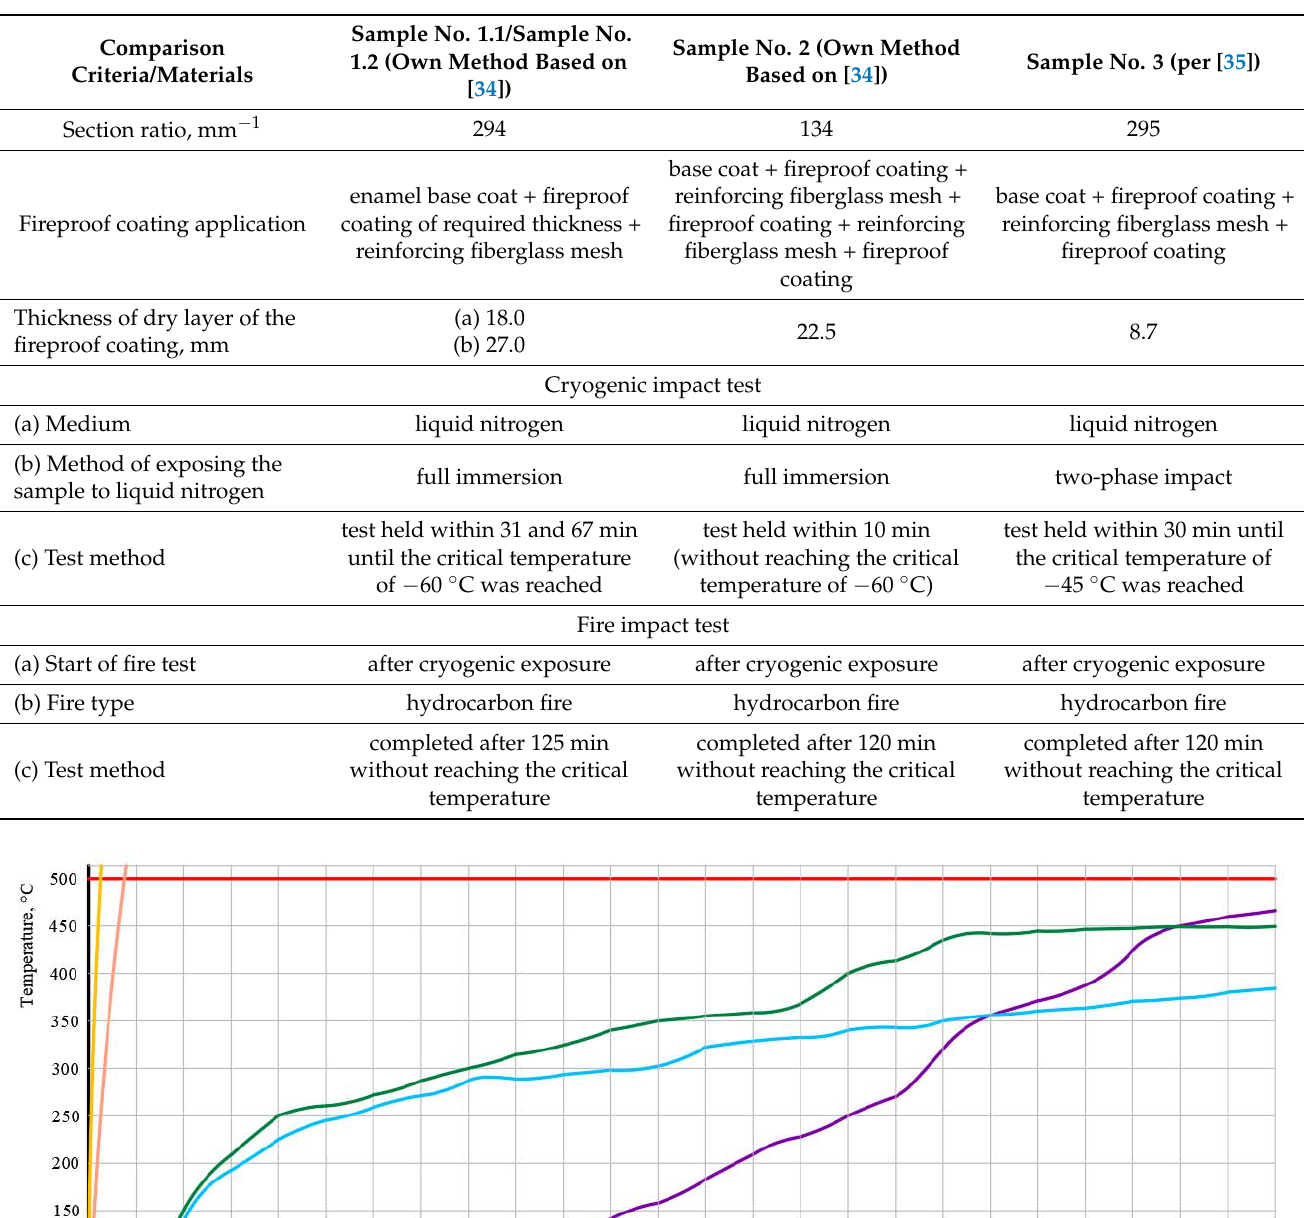
Table 2. Comparison between testing methods of fireproof coatings.